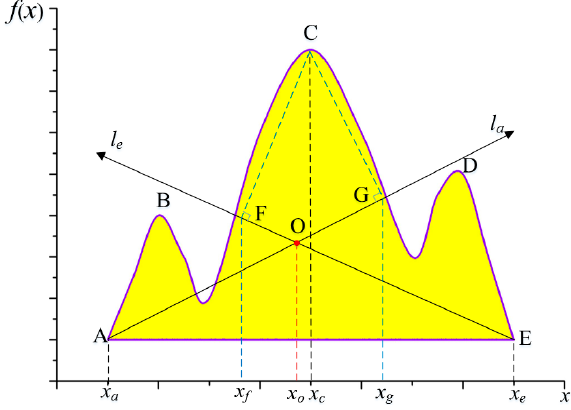
Figure 8. Determination of the gravity center by object-hanging.